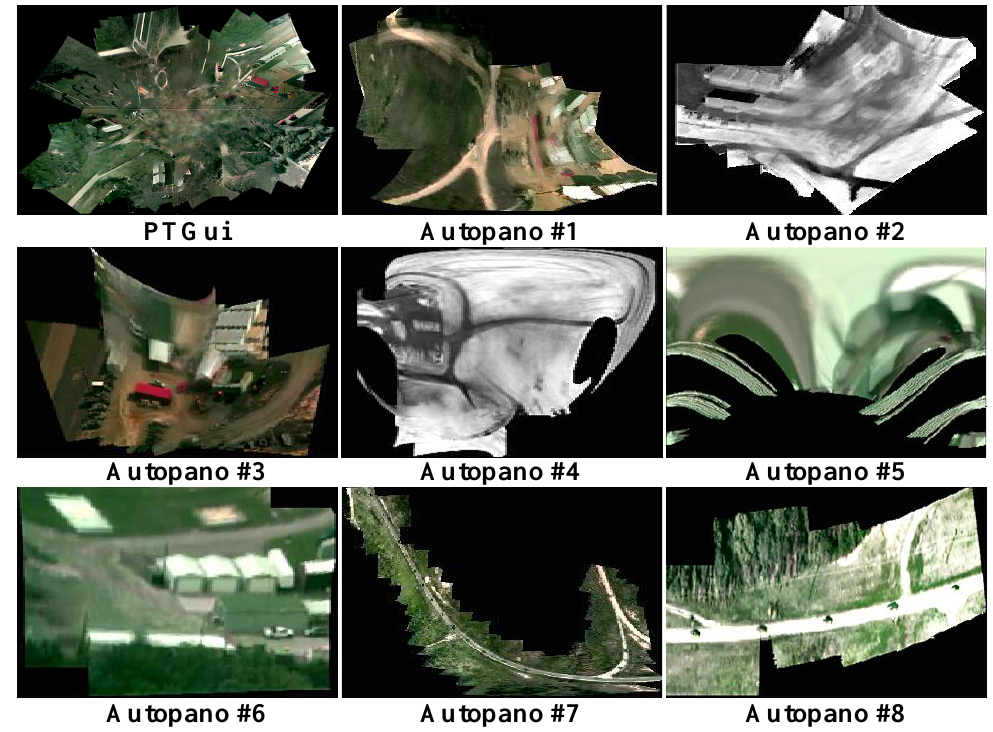
Figure 6. Example results of PTGui [21] and Autopano [22] from the VIRAT dataset with 2312